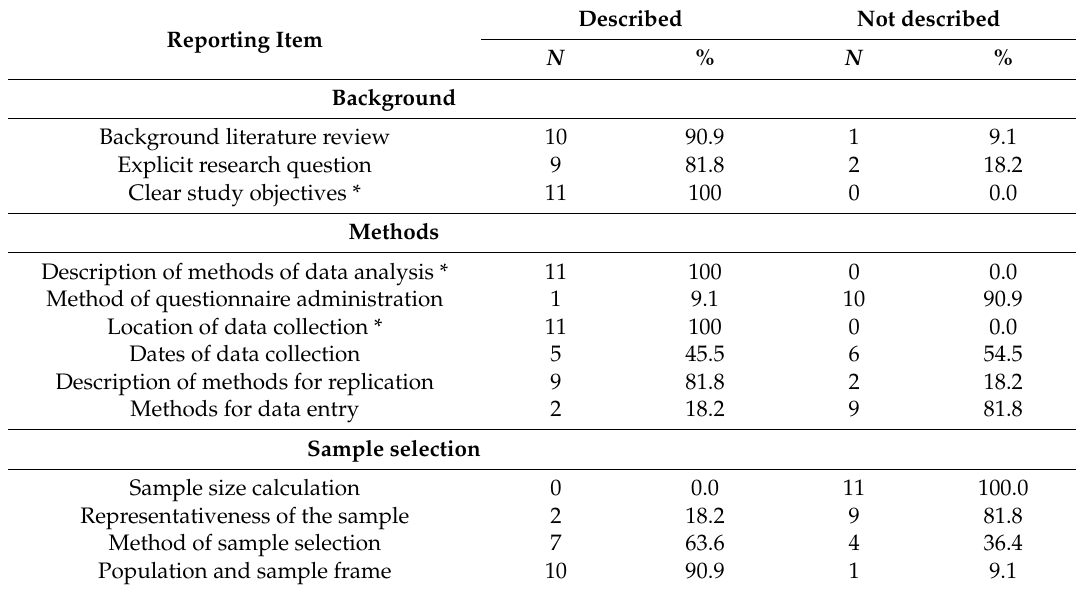
The quality of the survey studies in the development and verification of health literacy